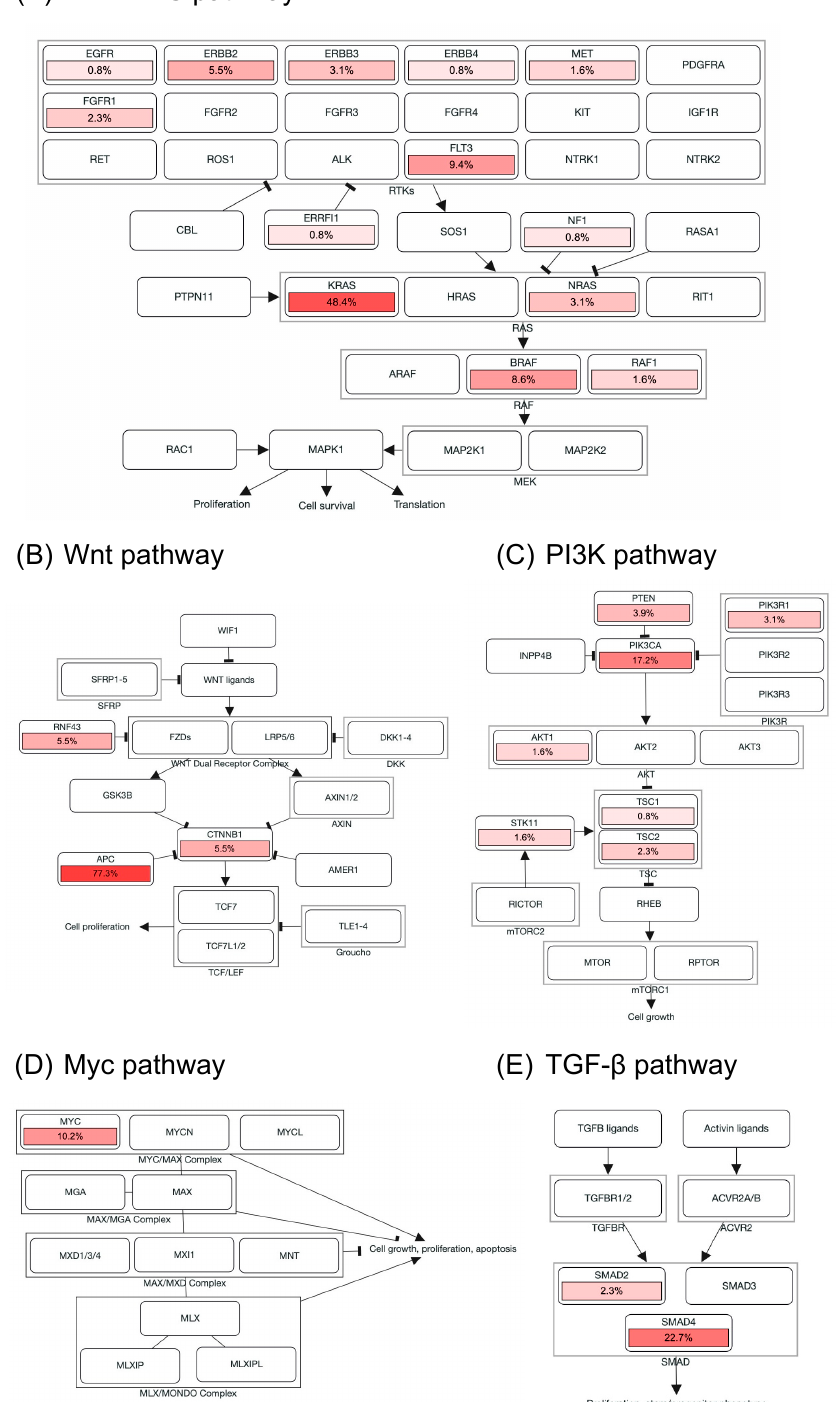
Figure 3. Alterations of signaling pathways in Taiwanese mCRC. Genomic alterations of the RTK- RAS ( A ), Wnt ( B ), PI3K ( C ), Myc ( D ), and TGF- β pathway ( E ). The color intensity represented the alteration frequency of pathway members. An arrow indicated an activation; a bar at the end of an edge indicated an inhibitory interaction.